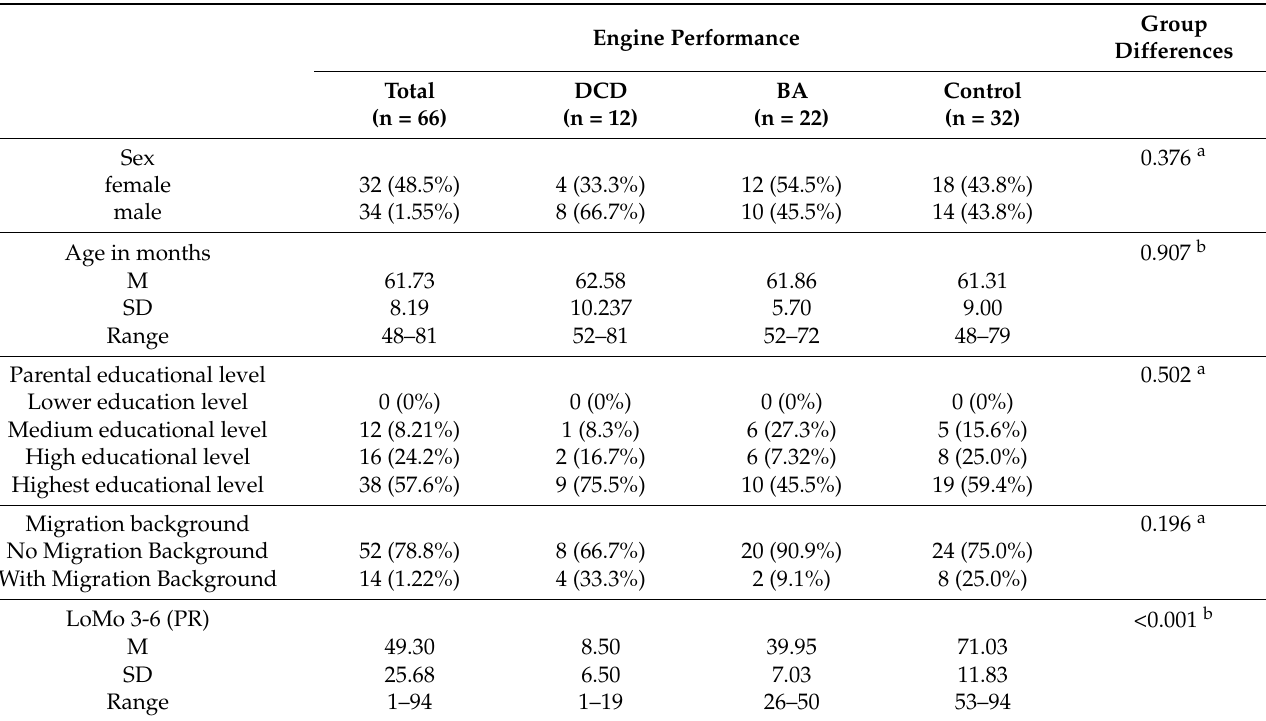
Table 1. Demographic description of the sample by